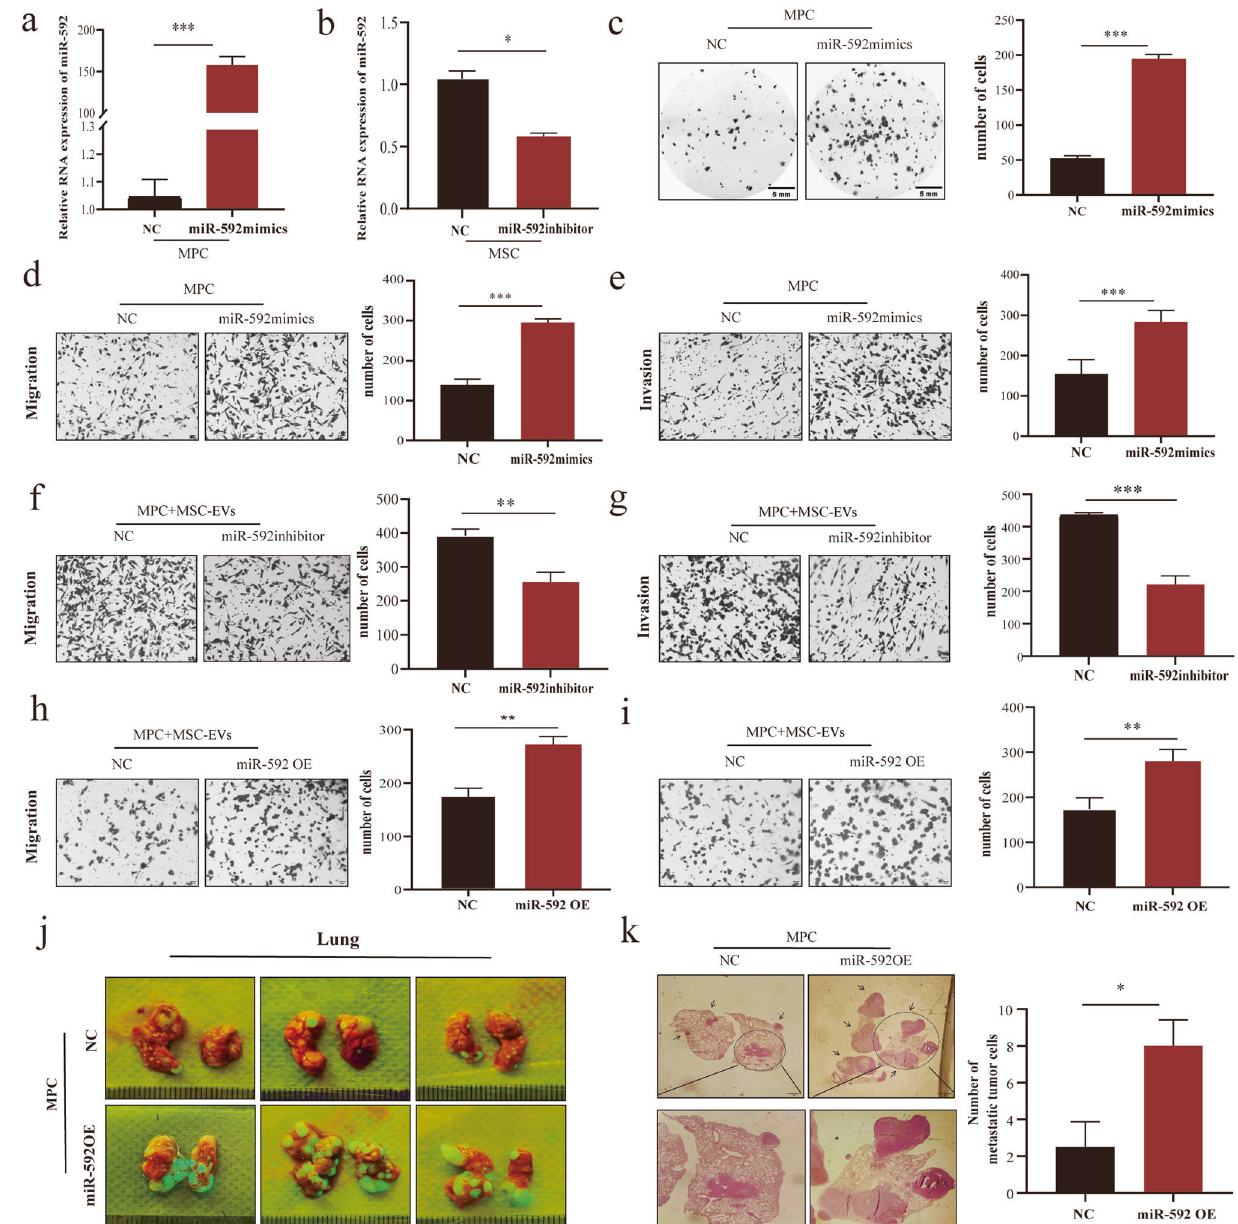
Fig. 3 miR-592 promotes the invasiveness of MPC cells in vitro and in vivo. a Overexpression ef fi ciency of miR-592 mimics treatment was con fi rmed in MPCs. b The knockdown ef fi ciency of miR-592 inhibitor was con fi rmed in MSCs. c – e Effects of miR-592 overexpression on migration, invasion and colonization of MPCs in vitro. f , g Effects of miR592 inhibitor treatment on the migration and invasion of MPCs by Transwell assay in vitro. h , i Overexpressing miR-592 MSC-EVs enhanced the migration and invasion of MPCs in vitro. j Lung metastases were observed in mice receiving the tail vein injection of MPCs-miR-592-OE (green). k H&E staining observation and quanti fi cation of lung metastases. (ns not signi fi cant; * P < 0.05; ** P < 0.01; *** P <